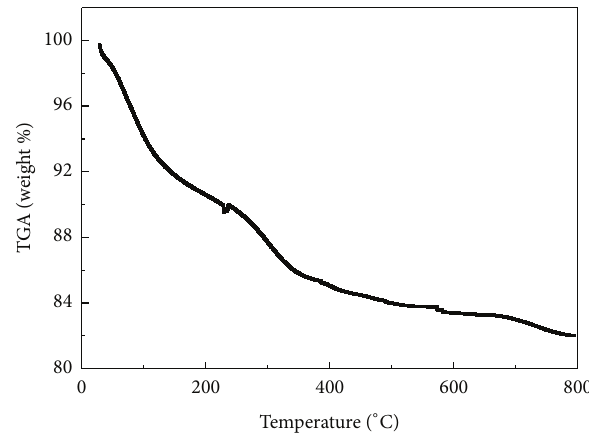
Figure 6: TGA curve of 0.4 wt% Pt-C/TiO 2 powders.